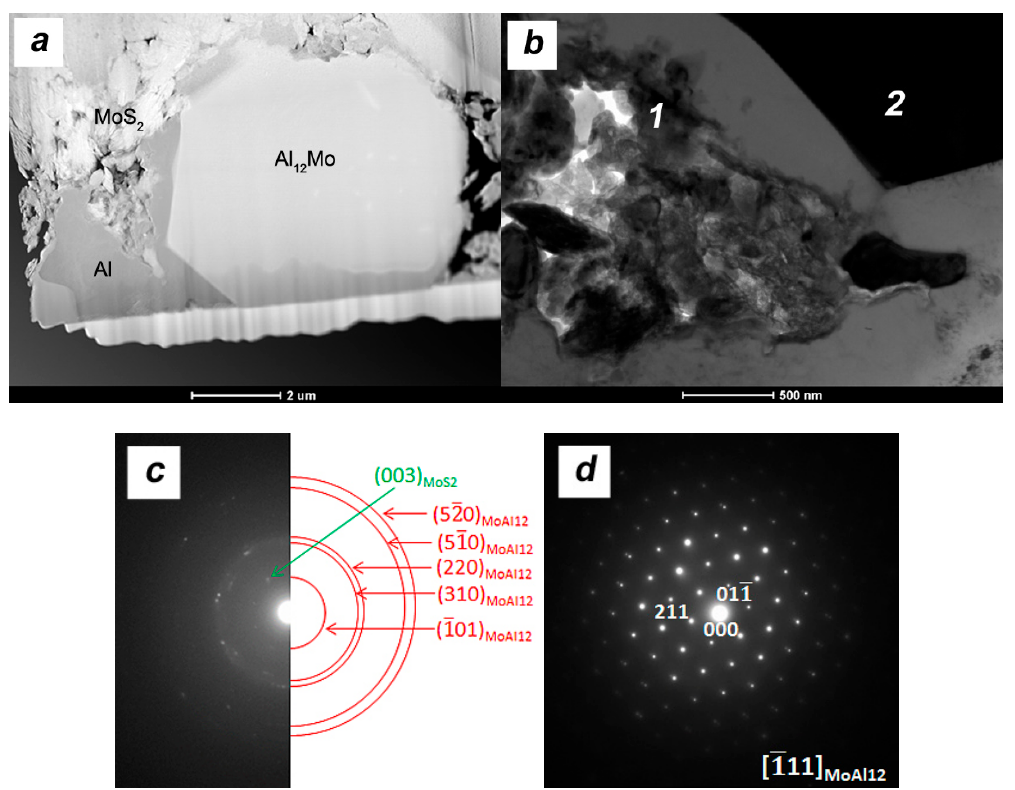
Figure 19. Microstructure of AA6061/MoS 2 10 vol % SPT samples ( λ = 1.5 center area) ( a ) and ( b ) microstructure; ( c ) diffraction pattern area 1; ( d ) diffraction pattern area 2.